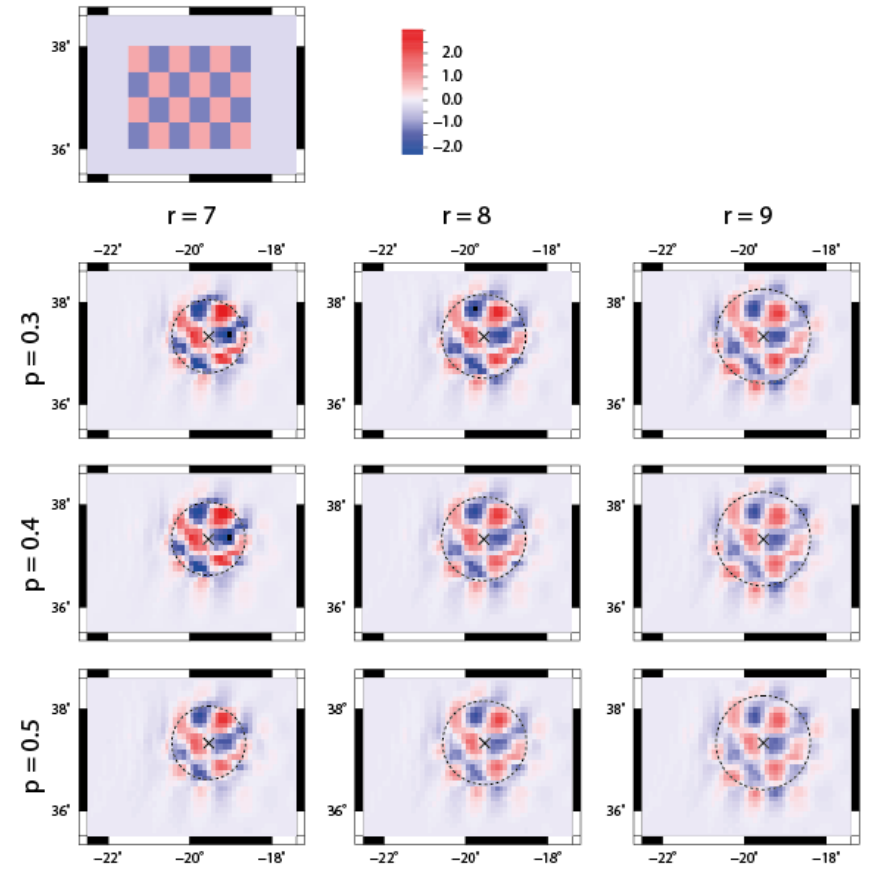
Figure 5. Chessboard test of the inversion approach. The source has alternating + 1/ − 1m displacements, and the synthetic waveforms are computed with a shallow water code for the locations that correspond to our tide gauge network. Inversion results for different values of r max (Eq. 4) and p (Eq. 5) are